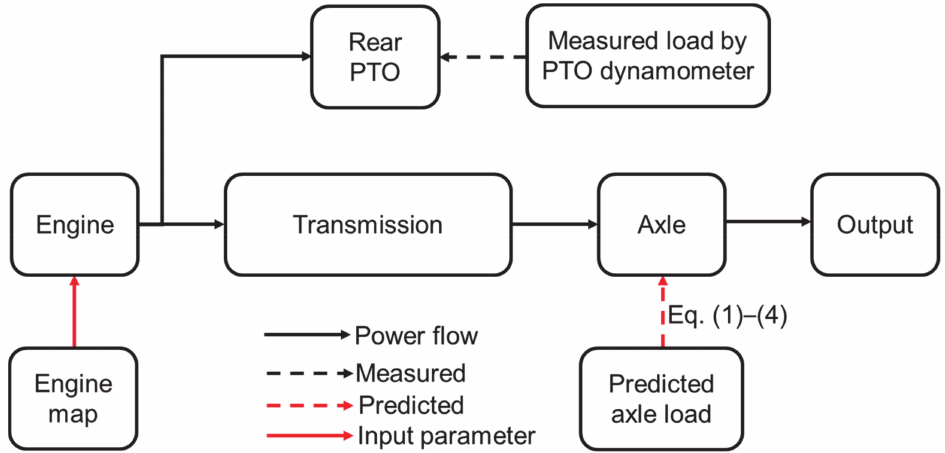
Figure 6. The block diagram for applied simulation parameters in this